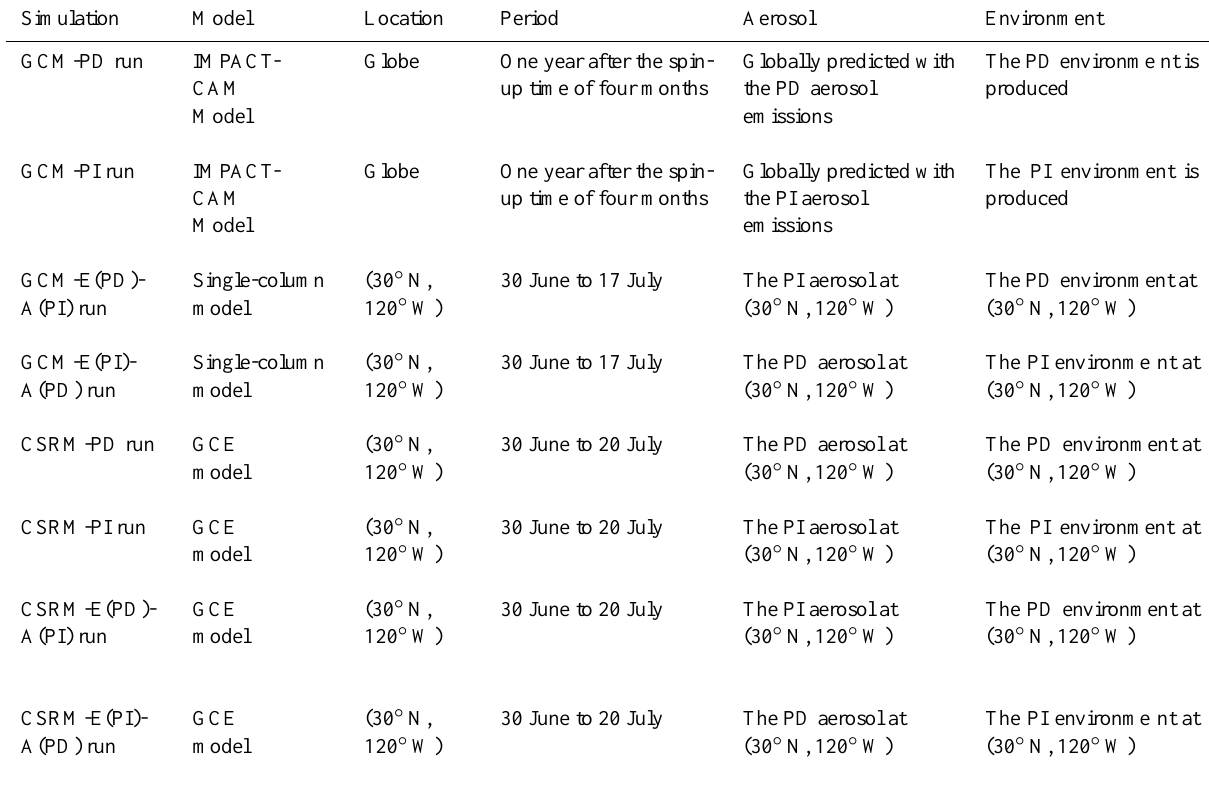
Table 1. Summary of